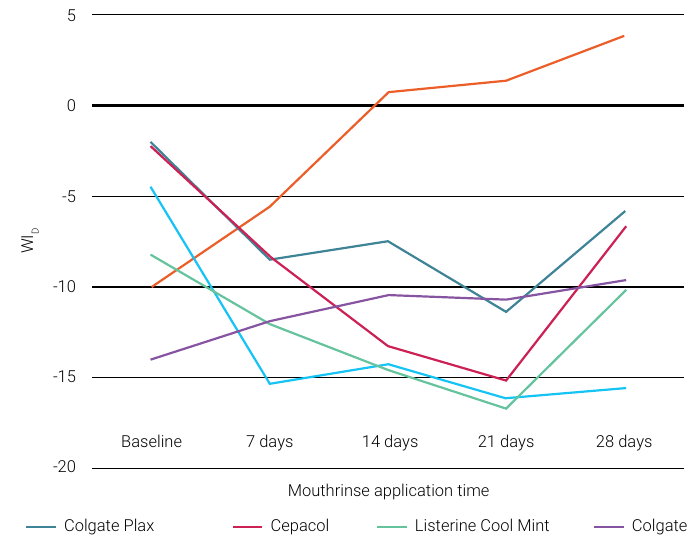
Figure 3. WI results of each mouth rinse over D